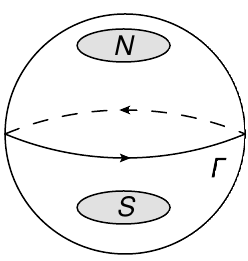
Figure 1 . A contour Γ divides the Riemann sphere into two hemispheres, with singularities in two regions N and S